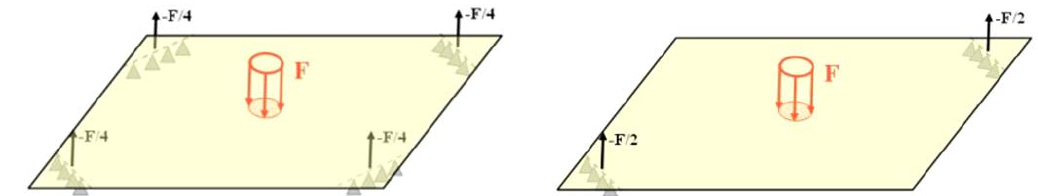
Figure 8: Loading scheme 2 to couple flexural stiffness in x and y (left) and loading scheme 3 to couple flexural and torsional stiffness